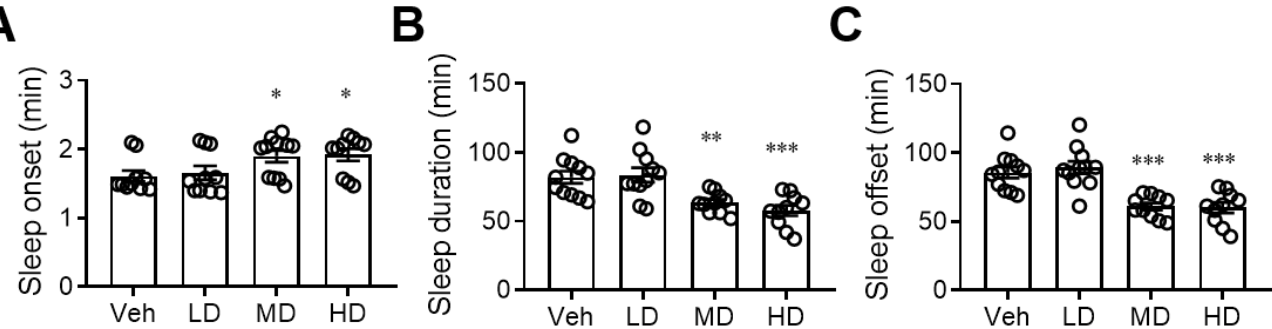
Figure 2. Sleep duration of ethanol-injected mice is diminished by coral hydrate treatment. C57BL/6 mice were treated by oral gavage with 105 mg/kg coral hydrate (Low dose group; LD), 210 mg/kg coral hydrate (Medium dose group, MD) or 420 mg/kg coral hydrate (High dose group; HD), and vehicle group (Veh), 420 mg/ kg coral calcium dissolved in 3% carboxymethyl cellulose. The coral hydrate was administered for seven days before intraperitoneal injection of ethanol. The time of sleep onset ( A ), sleep duration ( B ), and sleep offset (time to waking) ( C ) were recorded. N = 11 mice in each group; * p < 0.05; ** p < 0.01; *** p < 0.001 as compared with vehicle group.